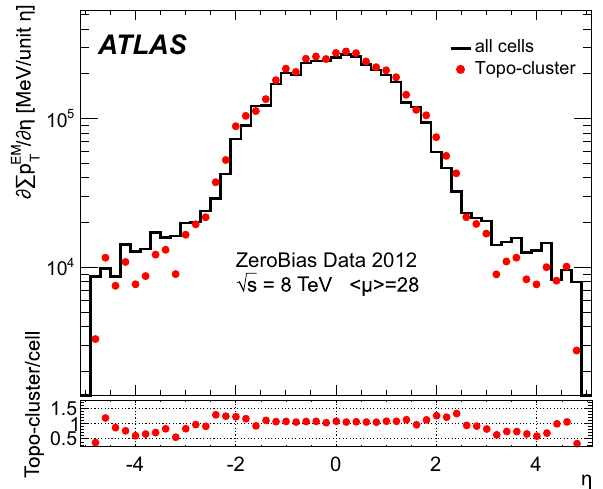
Fig. 26 The reconstructed average transverse momentum flow on EM scale,measuredwithtopo-clustersinbinsof η using (cid:7) (cid:20) p EM (41) and with all calorimeter cells in the same η -bins using (cid:20) p EM given in Eq. (42), in 2012 MB